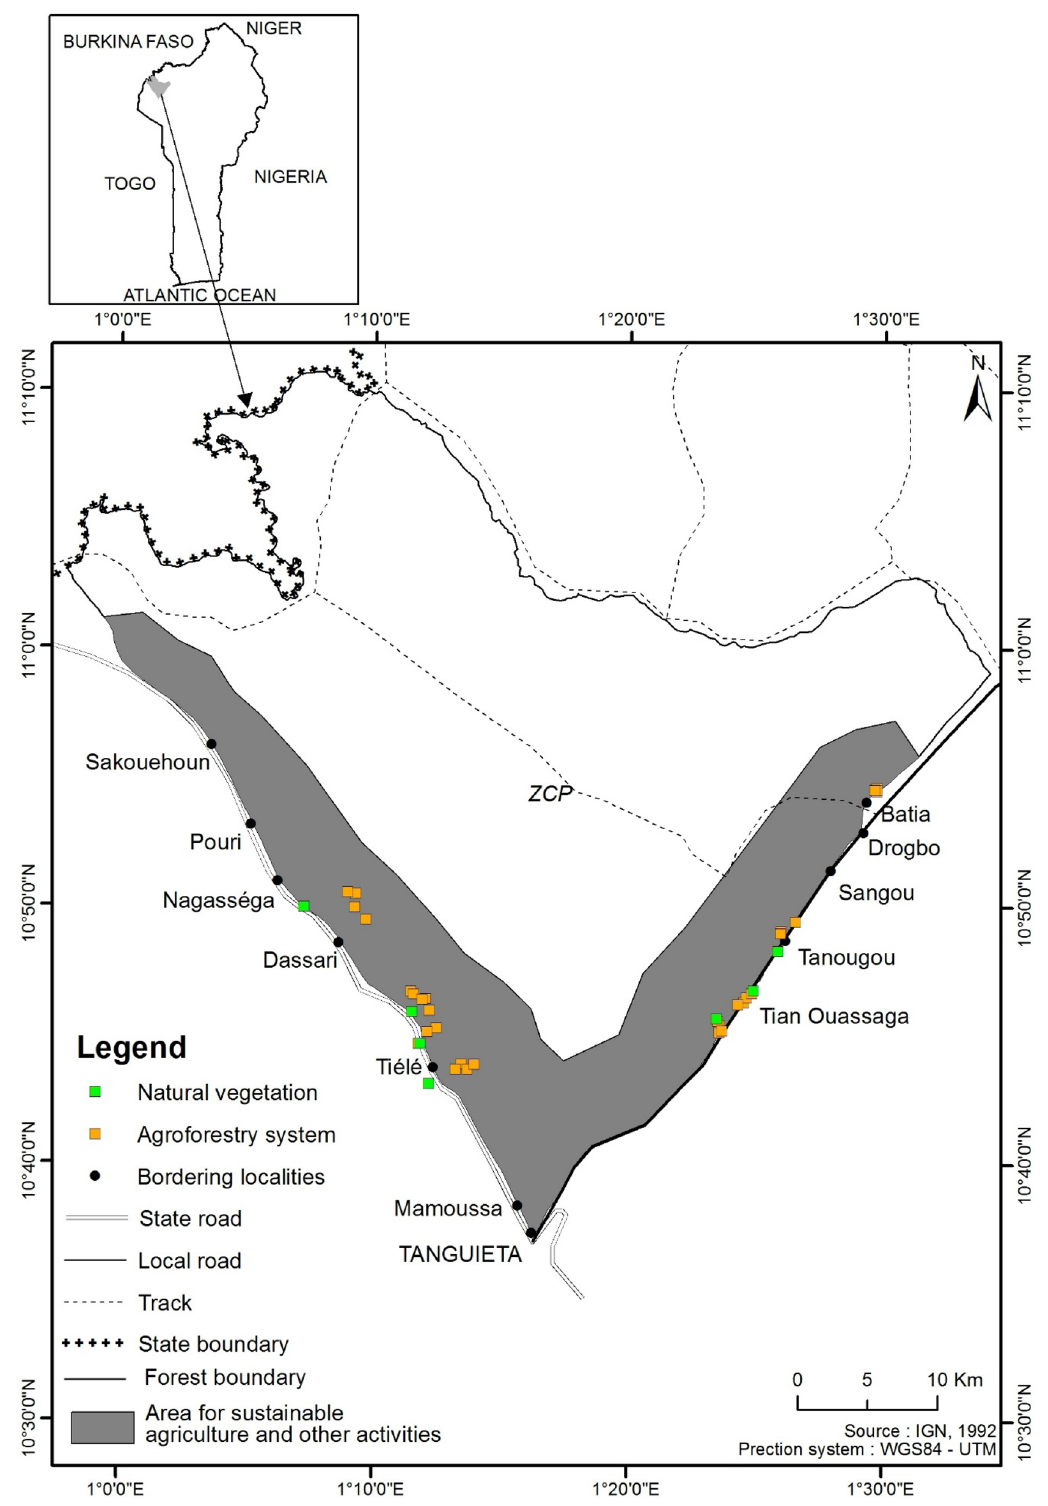
Figure 1. Map of the hunting zone of the Pendjari Biosphere Reserve in Northern Benin showing study sites in agroforestry parklands that are established in the transition zone where sustainable agricultural activities are allowed. The transition zone is composed of two narrow strips of land on each side of the hunting zone (grey). On the Tanguieta-Batia road axis, populations are constrained by the Atacora Chain of Mountains which boarded the eastern side of the hunting zone limiting agricultural expansion. The map was created using ArcGIS 10.5.1 (ESRI, https:// www. esri.